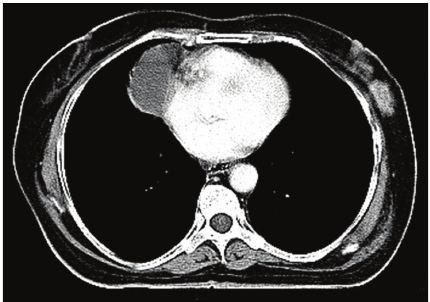
Figure 3: A well-defined lesion of size 4.1cm × 4.6 cm in the middle lobe of right lung abutting the mediastinal pleura along with left axillary lymphadenopathy.